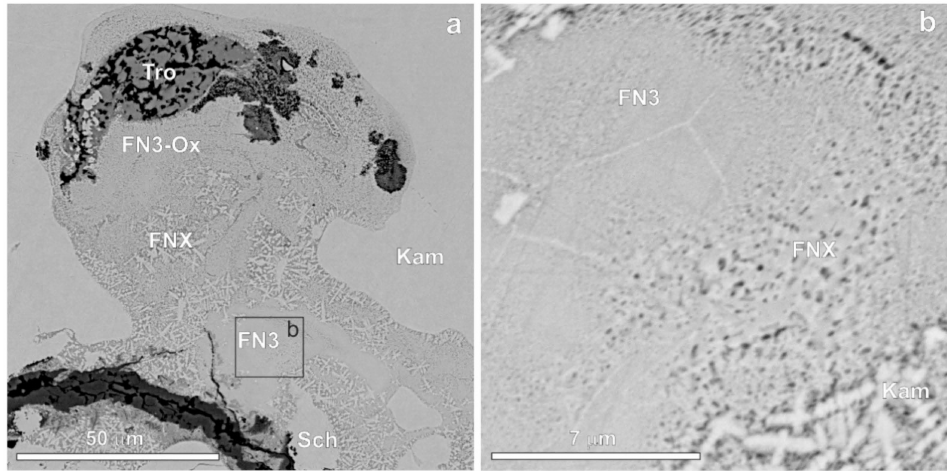
Figure 3. Nanocrystalline (Fe,Ni) 3 (P,S) zones surrounded by non-stoichiometric FNX with clear dendrites of (Fe,Ni)-metal (Site 10–12 in Table S1).